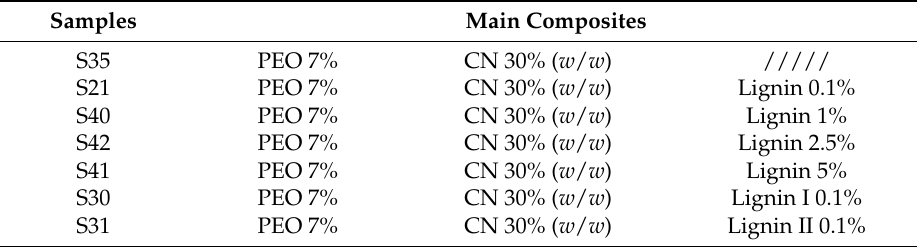
Table 2. Chitin nanofibrils-Ag/bio-lignin, chitosan/polypeptides/poly (ethylene) oxide (PEO) non-woven